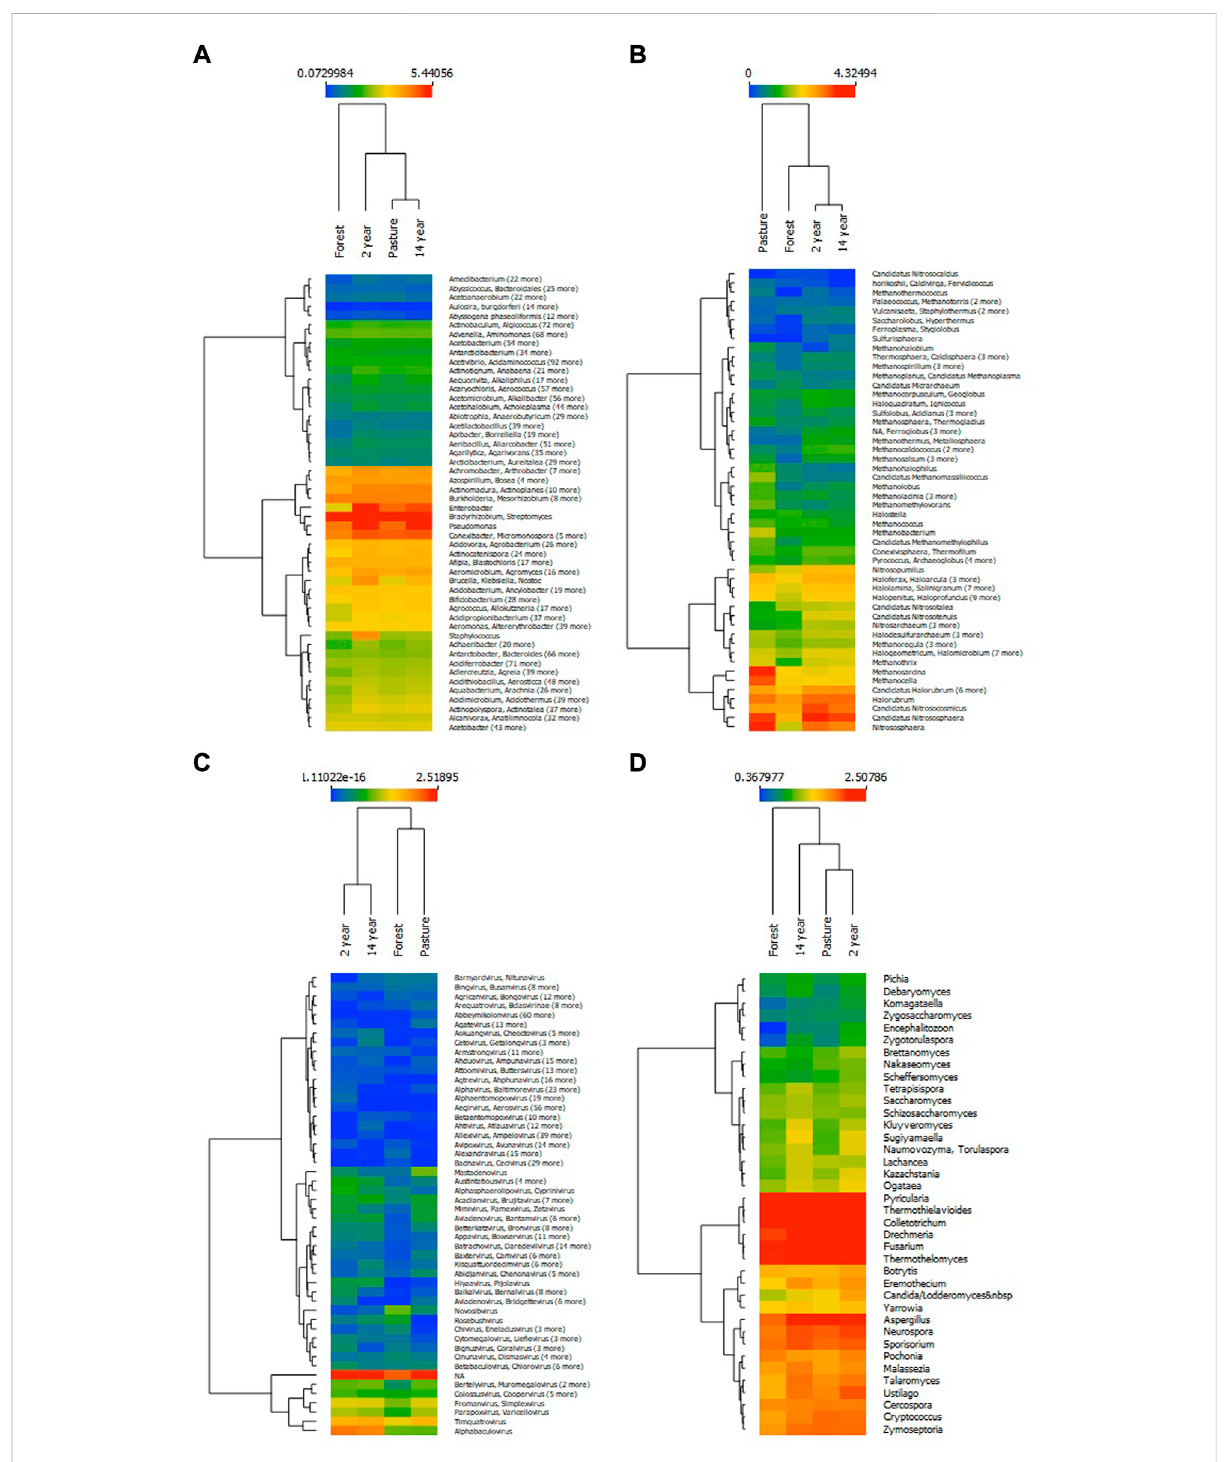
FIGURE 2 Heat map ofgenusabundance ateach site of organisms (A) bacteria, (B) archaea, (C) virus and (D) fungi, grouped using the k-means